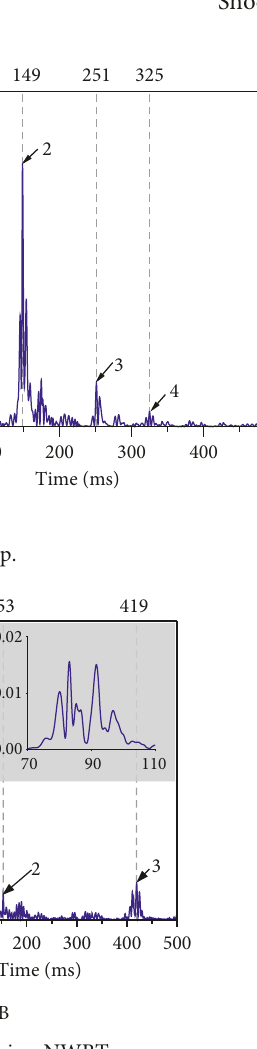
Figure 14: Time-energy distribution of AOp with working NWBT.